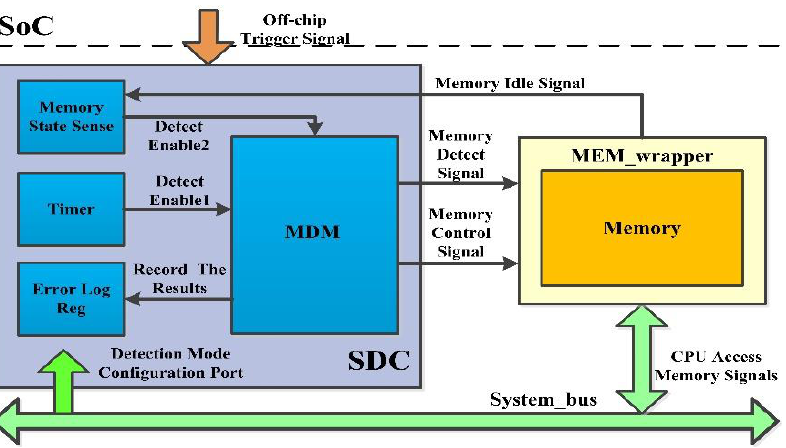
Figure 3. The overall figure of the run-time detection architecture for memory security (RDAMS).